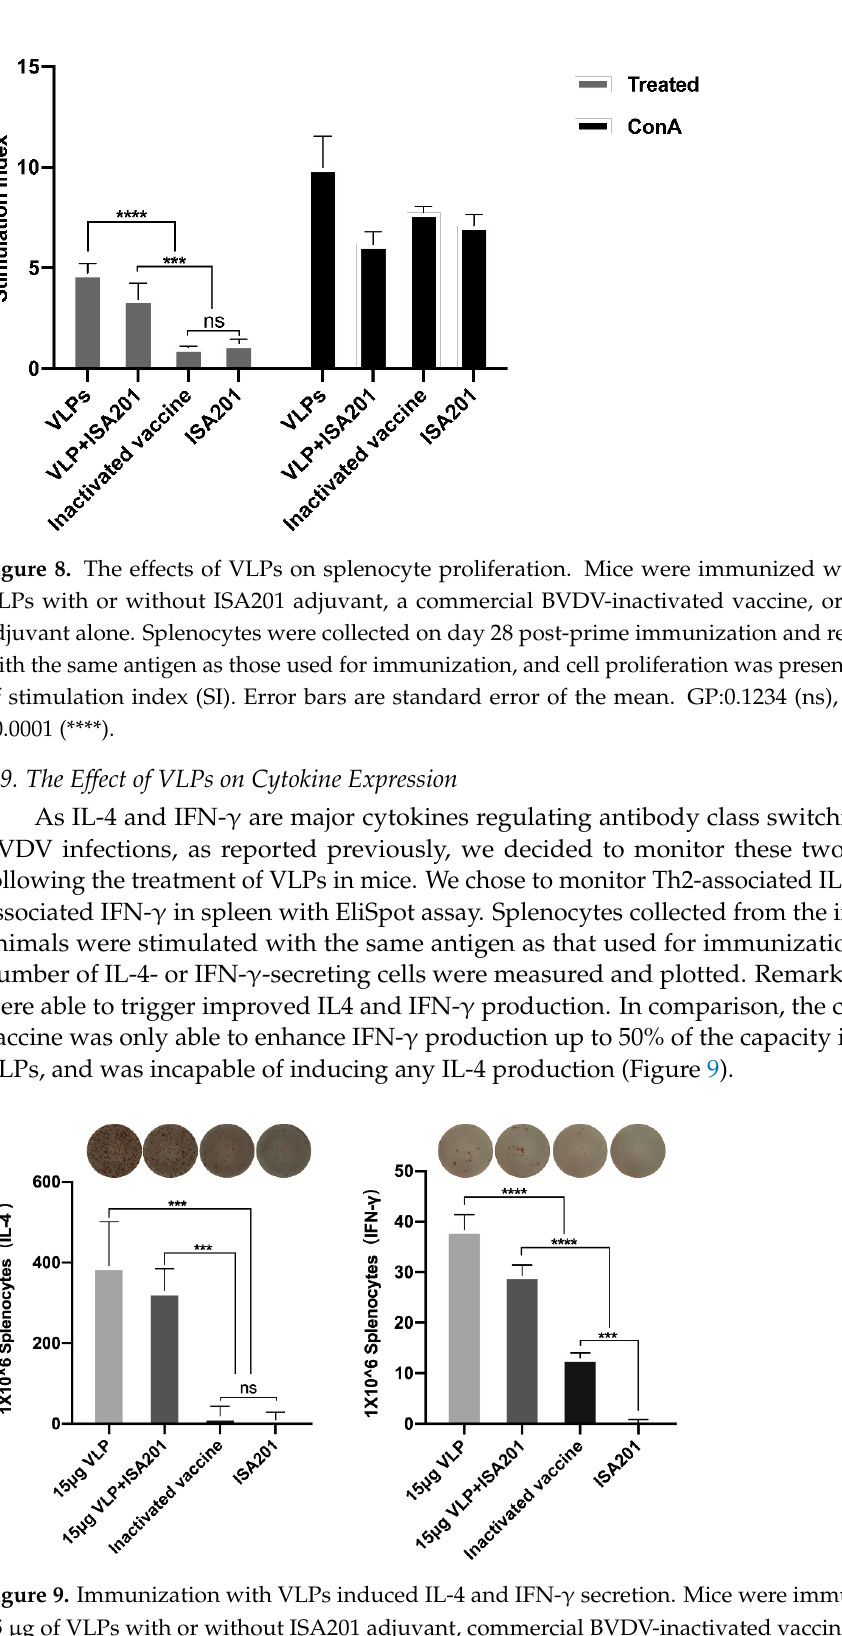
Figure 9. Immunization with VLPs induced IL-4 and IFN-γ secretion. Mice were immunized with 15 μg of VLPs with or without ISA201 adjuvant, commercial BVDV-inactivated vaccine, or ISA201 adjuvant alone; splenocytes were collected on day 28 post-prime immunization and re-stimulated with the same antigen as those used for immunization. Data are presented as number of IL-4- and IFN-γ-secreting cells per 10 6 splenocytes. Error bars are standard error of the mean. GP:0.1234 (ns), 0.0002 (***), <0.0001 (****).